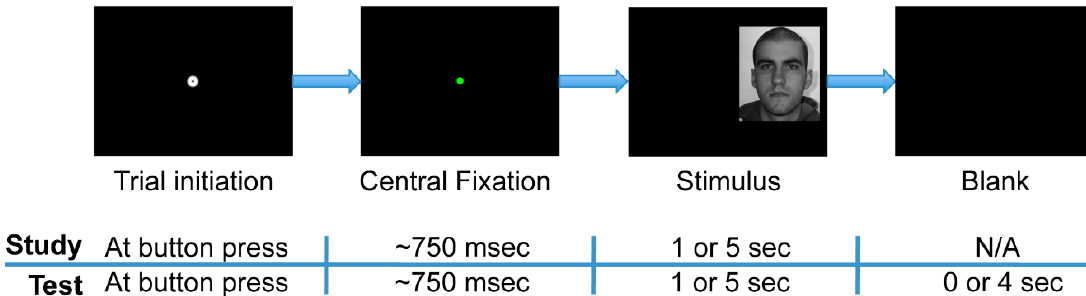
two of these blocks, and five-second limits existed in the other two blocks. Furthermore, all of the “old” faces in one of the two short-presentation blocks in the test phase were faces that had had short presentations in the study phase, while those in the other test phase short-presentation block had had long presentations in the study phase. This property likewise held for the two long-presentation blocks in the test phase. For all test phase trials, participants were given up to five seconds following stimulus onset to respond, regardless of the presentation time limit of the stimuli. The trial ended immediately upon response, so the one- and five-second stimulus presentation limits within the test phase were only upper limits, not enforced viewing times.